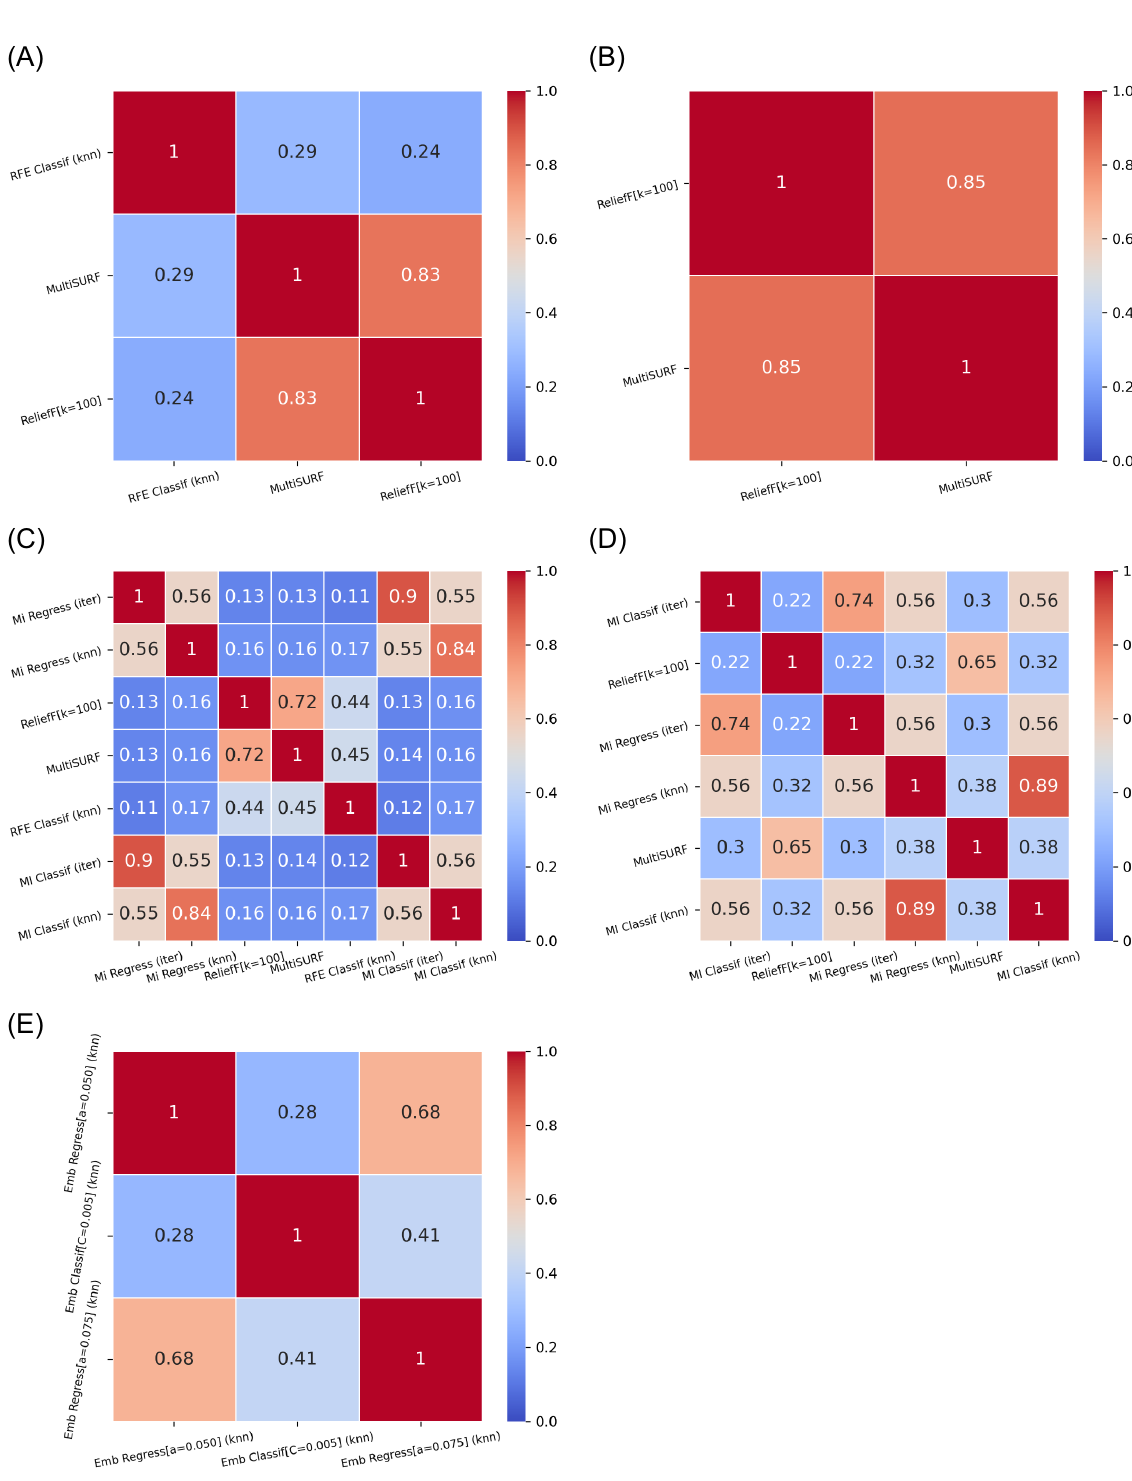
Fig 2. Jaccard similarity index between feature subsets. For all pairs of stable algorithms, these grouped by n averaged over M = 100 bootstrap samples. ( a ) n FS = 5. ( b ) n FS = 10. ( c ) n FS = 20. ( d ) n FS = 40. ( e ) n FS not pre-fixed.